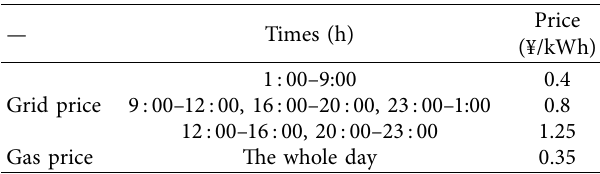
Figure 5: Te general overview of the case. Table 3: Electricity and heat